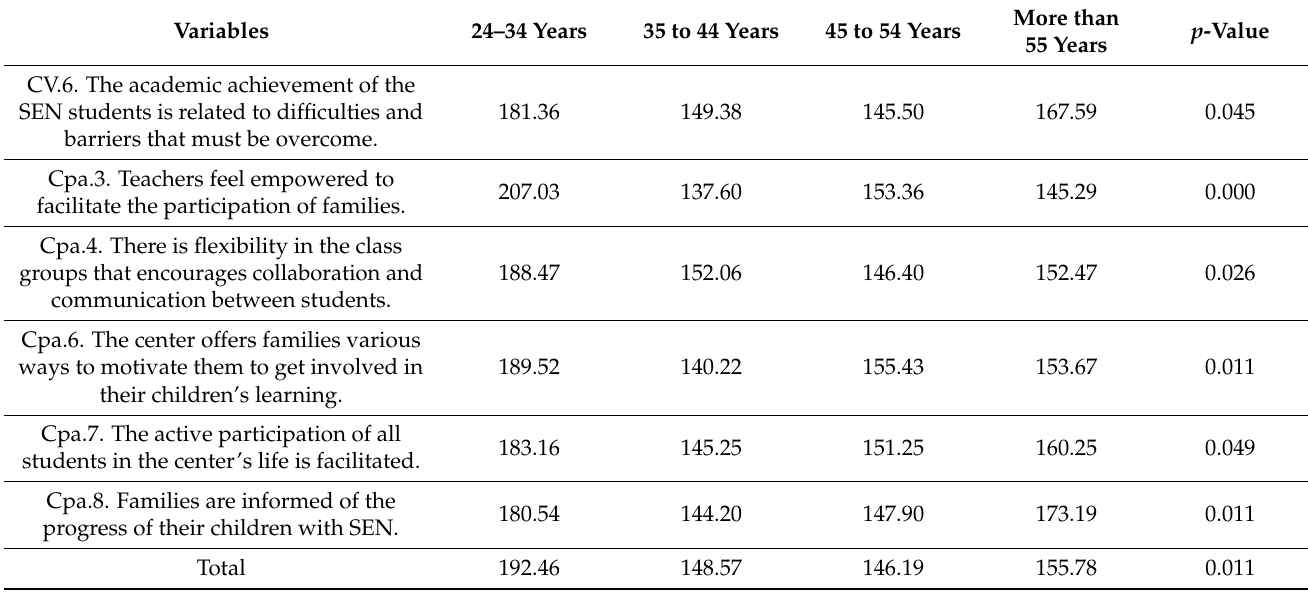
Table 4. Kruskal-Wallis analysis by teachers’ age.